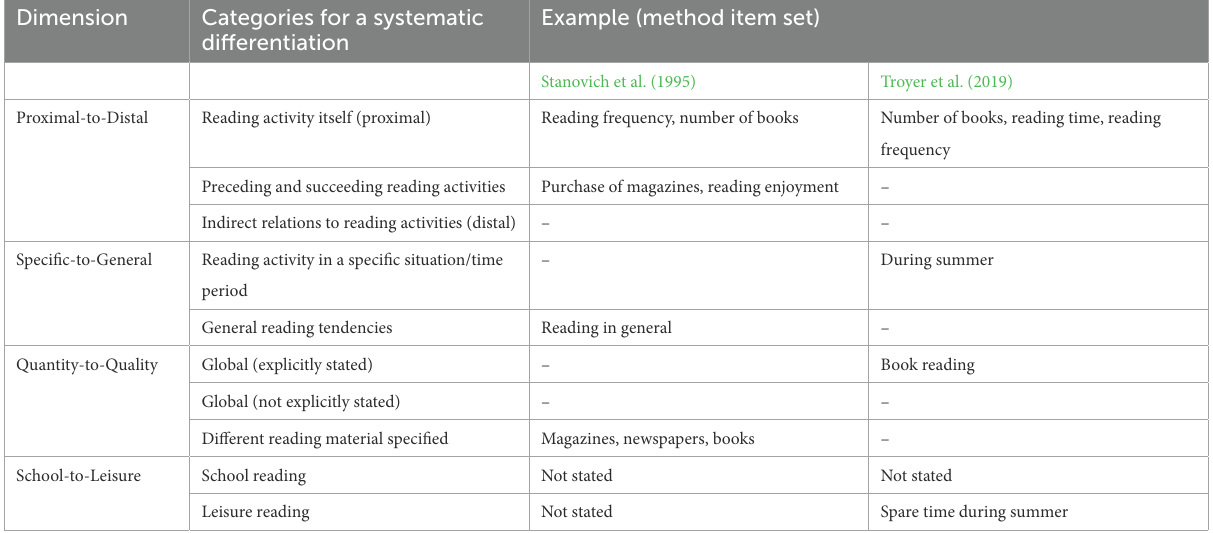
TABLE 2 Multidimensional classification system for reading behavior measures in large scale assessments and surveys. Dimension Categories for a systematic Example (method item set) differentiation Stanovich et al. (1995) Troyer et al.